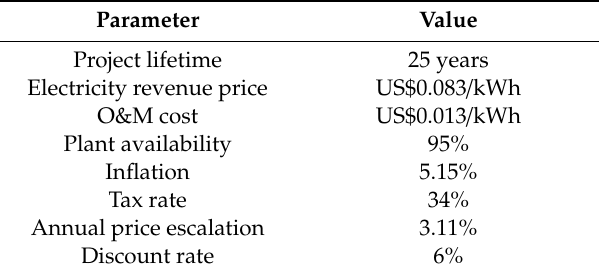
Figure 6. Specific investment costs for the optimum cycles. Table 7. Project Profitability Analysis Parameters.